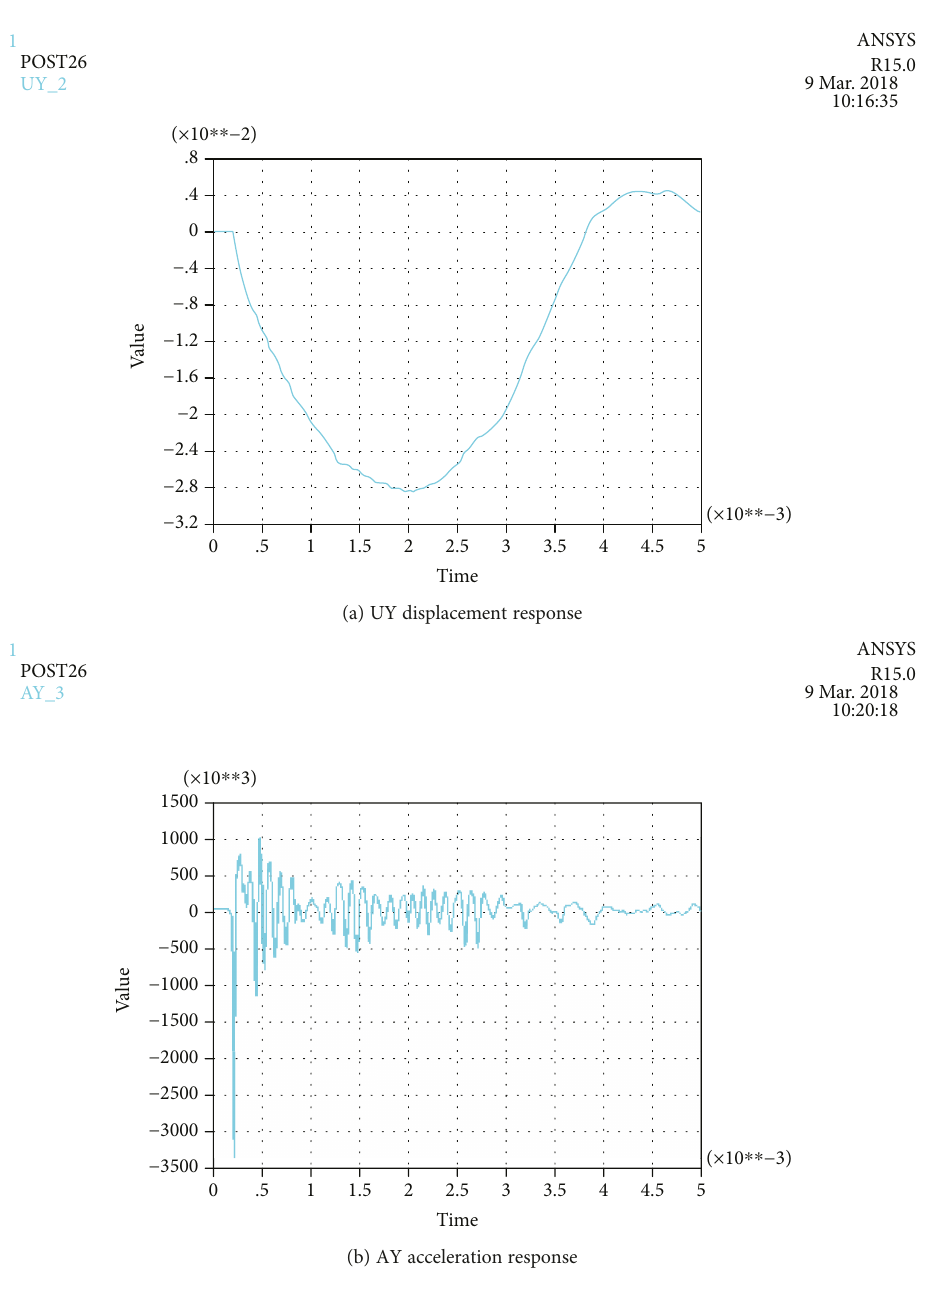
Figure 17: Dynamic response of the No. 2